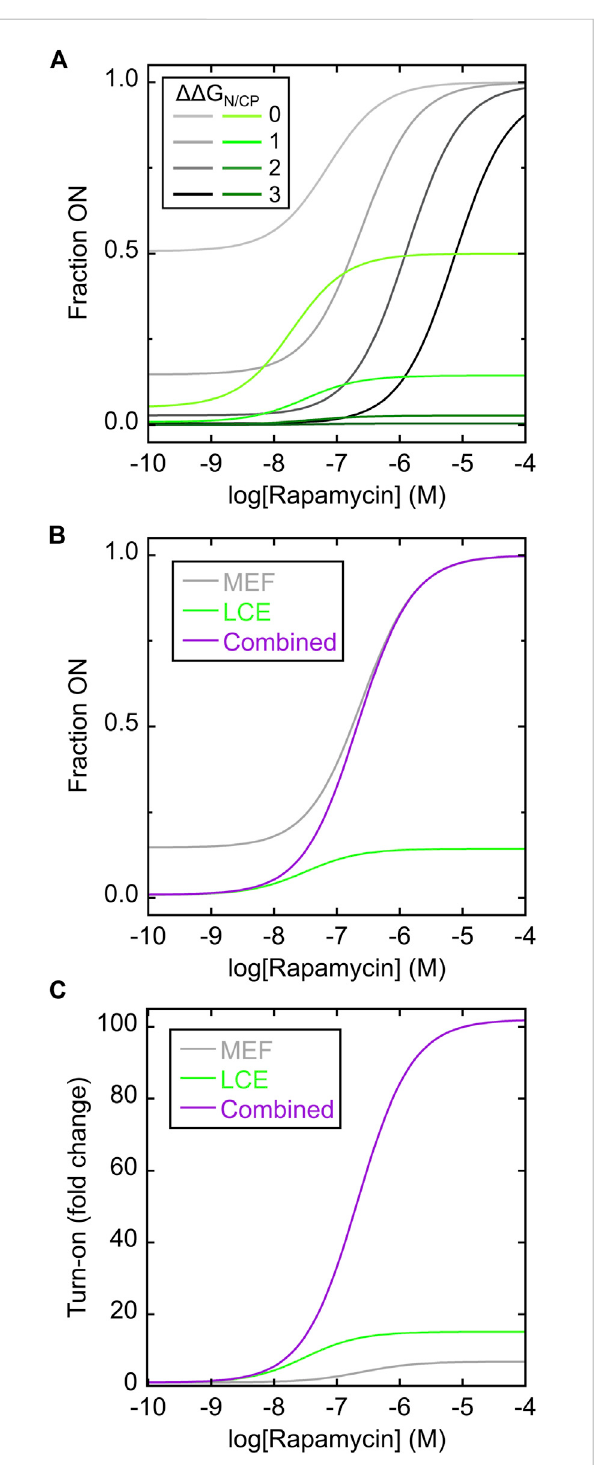
FIGURE 2 Simulating MEF-only, LCE-only, and MEF-LCE switching mechanisms. (A) Rapamycin response curves of the MEF-only switch (grey lines; c.f. Figure 1B) and the LCE-only switch (green lines; c.f. Figure 1C) were simulated using the values of ΔΔ G N/CP indicated in the inset (in units of kcal/mol). K d of rapamycin binding to folded FKBP and cpFKBP domains was set to 1 nM. The LCE penalty was set to − 2 kcal/mol. (B) The simulated response curve of the MEF-LCE switch(purple;c.f.Figure1D)combinedthelowbackgroundactivityof LCE-only switching (green) with the high activity ceiling of MEF-only